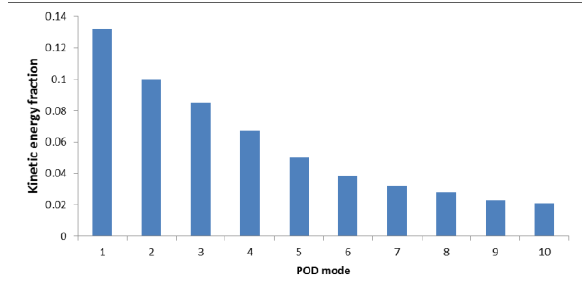
Fig. 6. Relative kinetic energy content of the first 10 POD modes, the leading edge .